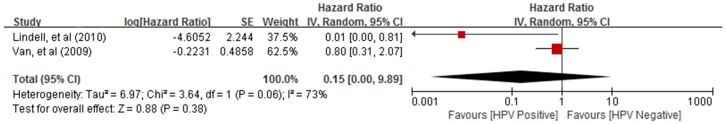
Forest plot for the association between human papillomavirus and disease-specific survival in patients with vulvar cancer.